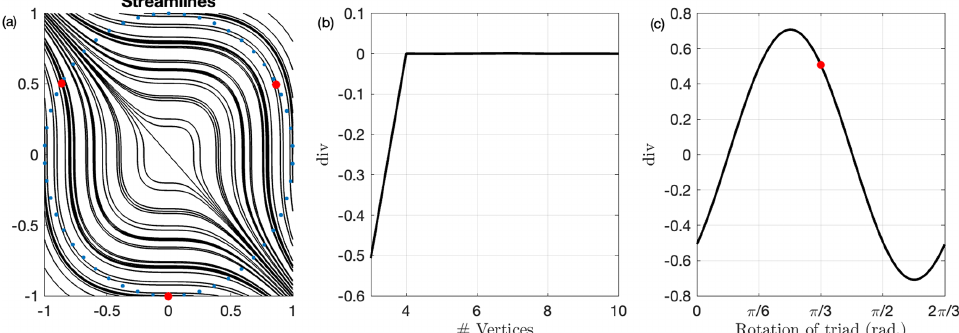
Figure A6. (a) Streamlines for the flow in Eq. (A14) with one example triad position (red) and unit circle of rotation (blue). (b) Average divergence as approximated by unit polygons as a function of the number of vertices used in the approximation. (c) Average divergence as approximated by a unit equilateral triad for all possible rotations, with divergence corresponding to (a) the triad in red.